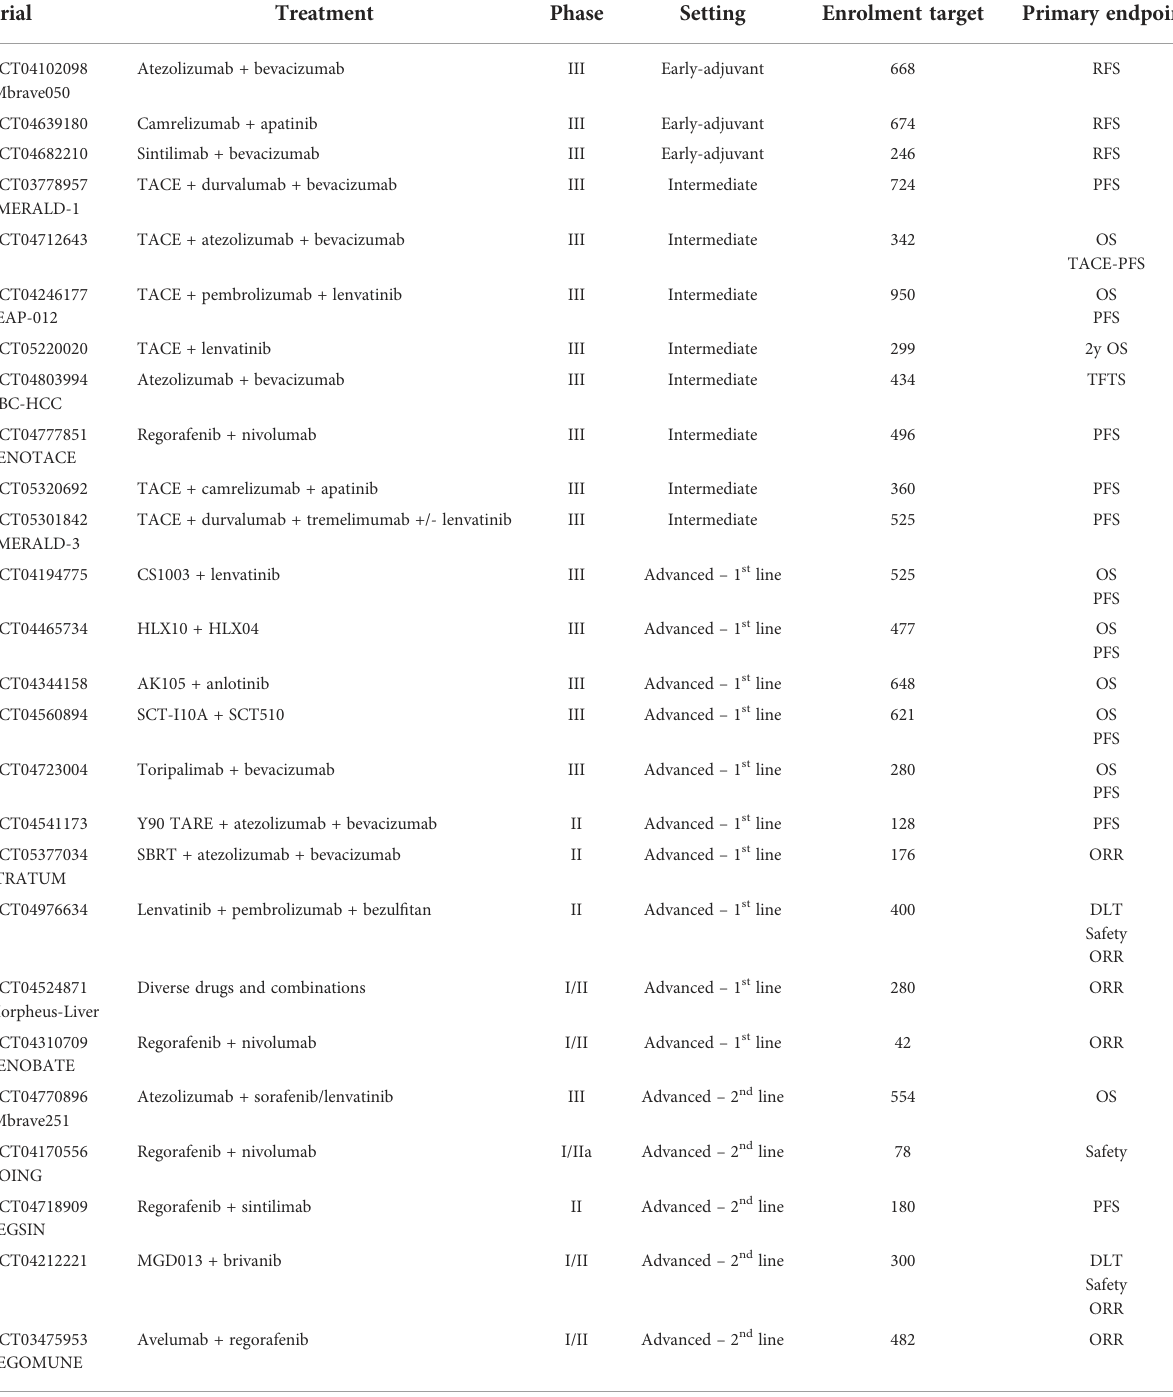
TABLE 3 Overview of selected trials testing novel antiangiogenic agents and combinations in HCC. Trial